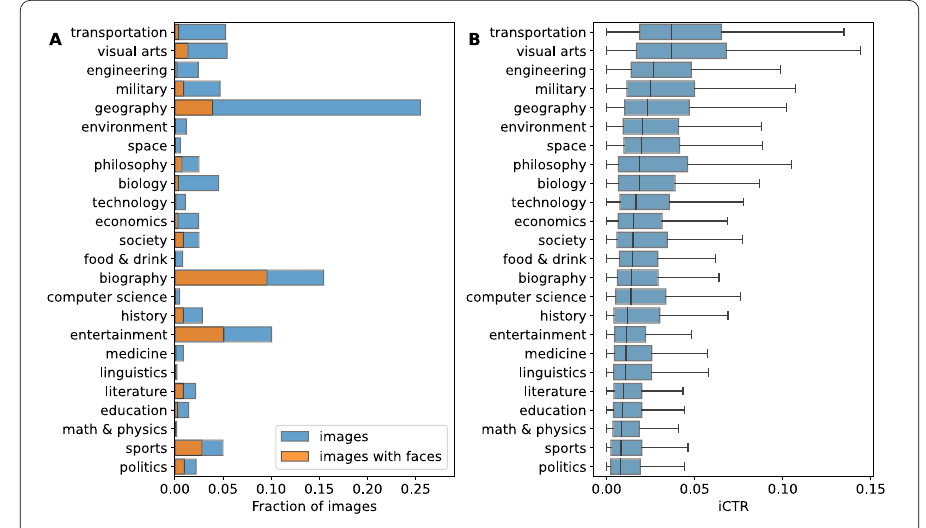
Figure 5 ( A ) Fraction of images by topic (in blue) and fraction of images with faces (in orange). ( B ) Image-specific CTR by article